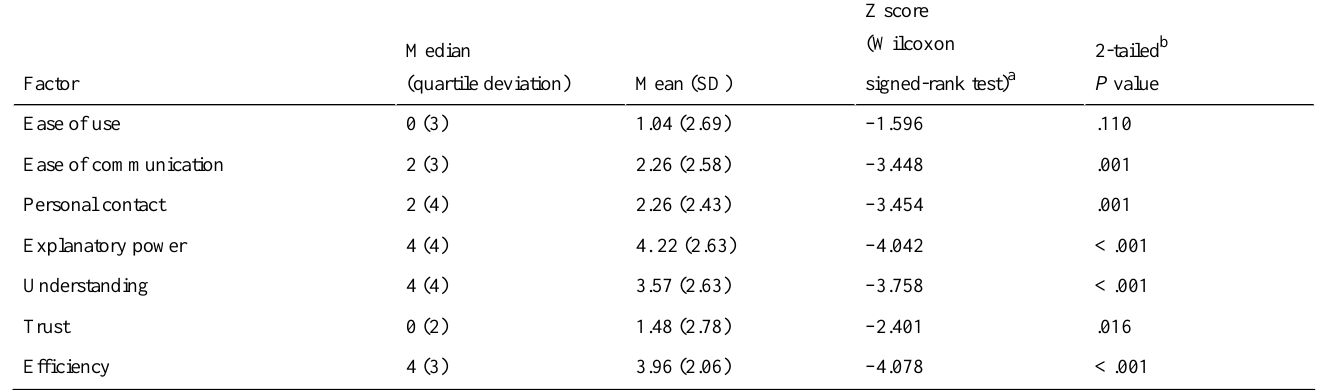
Table 1. Preference scores comparing AssistancePlus and telephone (N =